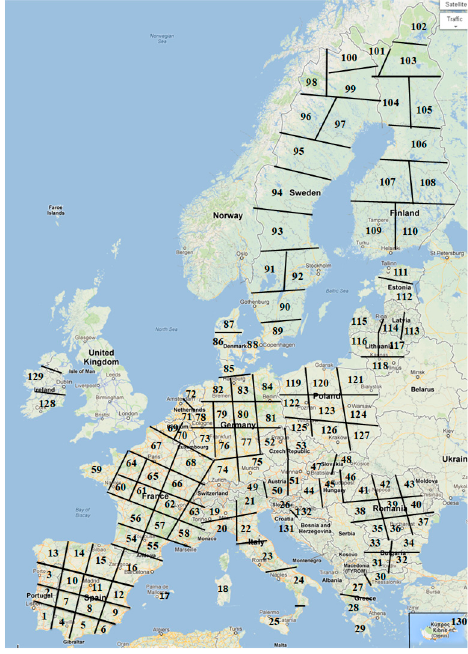
Figure 1. The European Union (EU)-27 divided into 132 zones. The map is taken from Google Maps (2020). EU-27: EU with 27 countries as of May 2020.